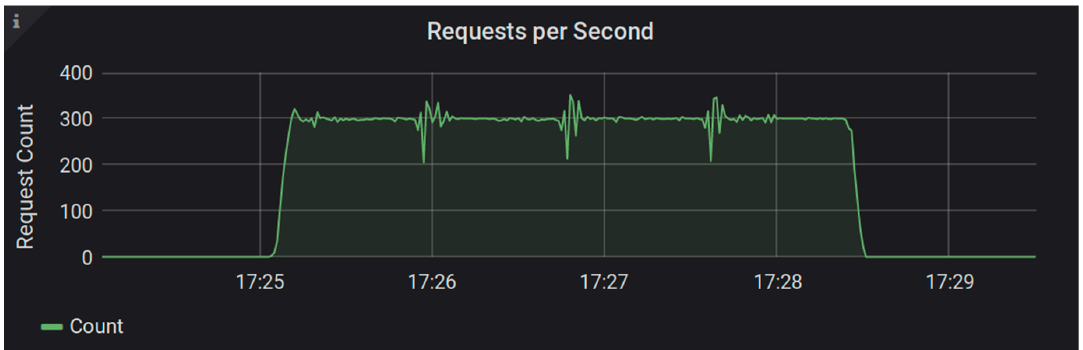
Figure 6. Trellis PostgreSQL system serves 300 requests per second.